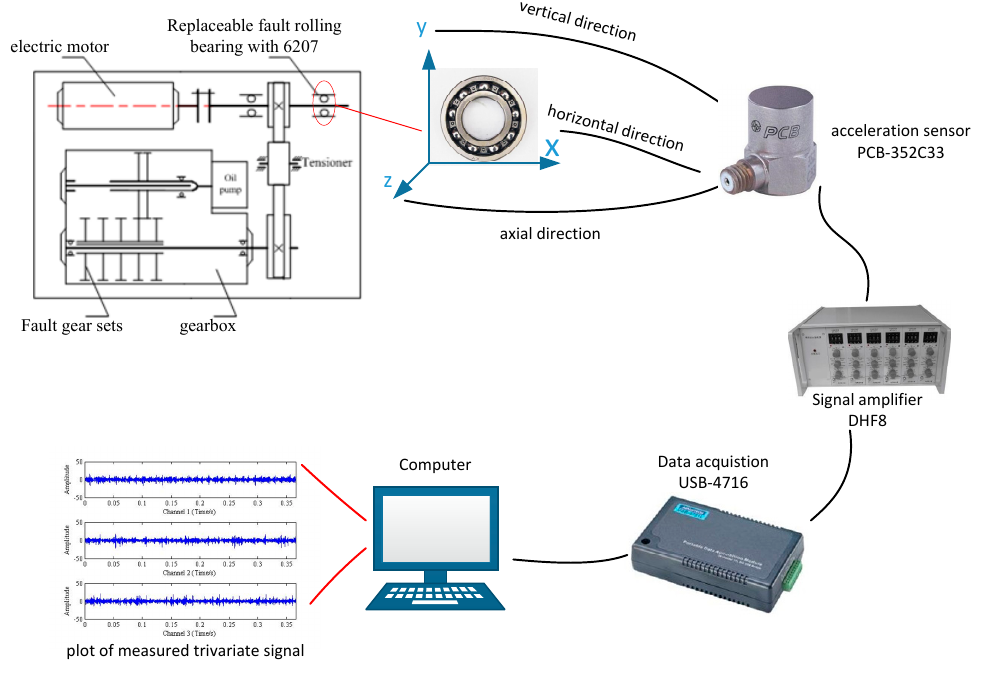
Figure 7. Testing flow chart for experimental bench. Table 1. The experimental parameters and fault frequency.